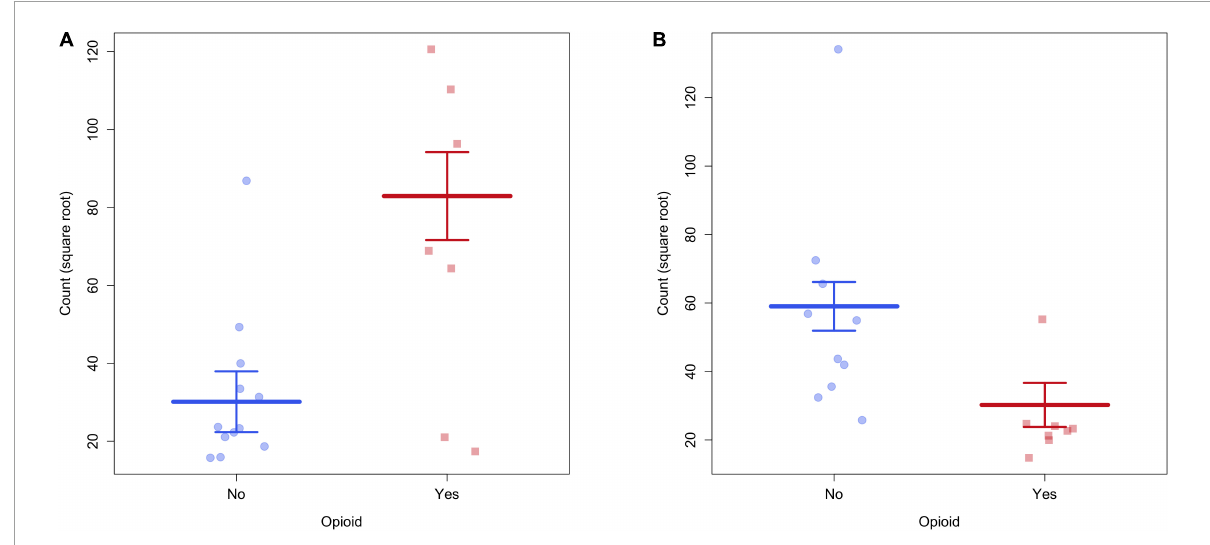
FIGURE1 (A) There was greater structural connectivity between the right superior frontal gyrus and right paracentral lobule in POE infants. (B) There was greater structural connectivity between right superior occipital gyrus and right fusiform gyrus in unexposed